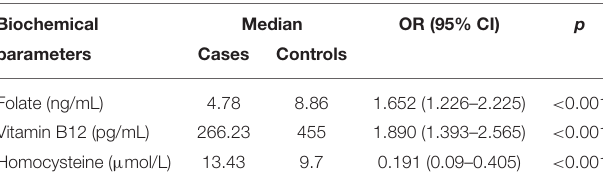
TABLE 3 | Serum folate, vitamin B12, and homocysteine levels of the study participants in three selected hospitals in Addis Ababa, Ethiopia